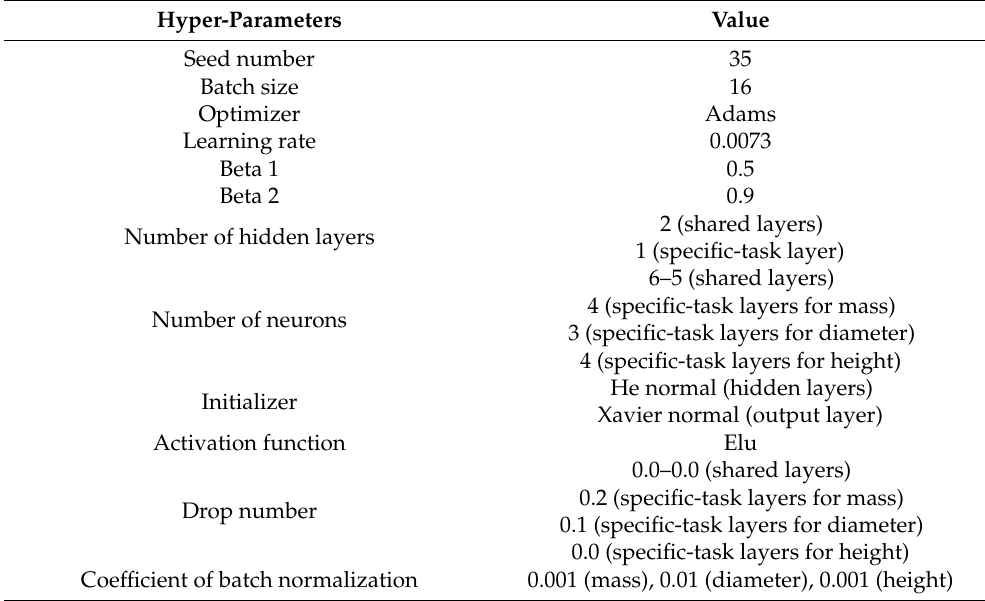
Table 11. Optimized hyper-parameters for the nonlinear relationship group (packing time was 3.0~39.0 s).